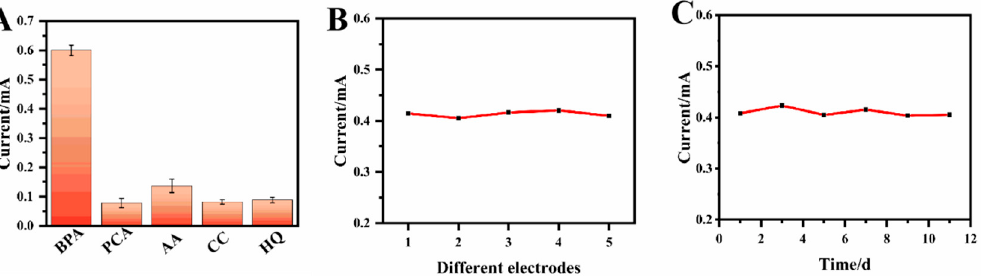
Figure 8. Investigating the selectivity of the MIP@CF sensor for 0.5 μ M of Bisphenol A or 5.0 μ M of the interferences ( A ), reproducibility ( B ) and stability ( C ) of MIP@CF electrodes for 5.0 μ M of BPA.